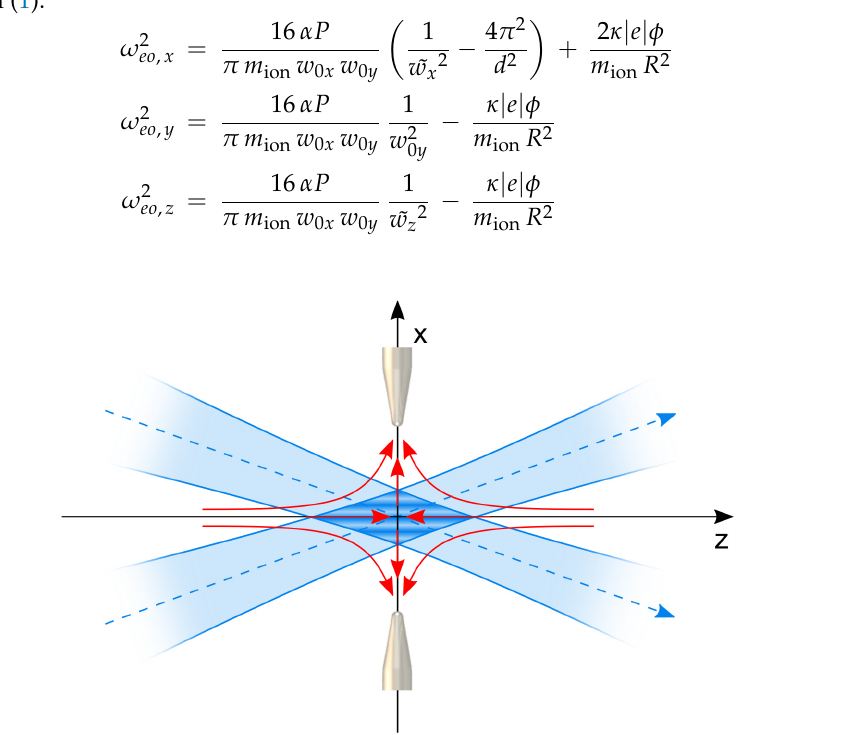
Figure 1. Sketch of the electro-optical trap, in which a static electric quadrupole potential (red arrows) is used for trapping ions along two orthogonal directions (y and z axes), while the confinement along the antitrapping direction (x axis) is provided by the interference pattern of two crossed Gaussian laser beams (drawn in blue). For positive ions, the electrodes generating the quadrupole potential must be negatively